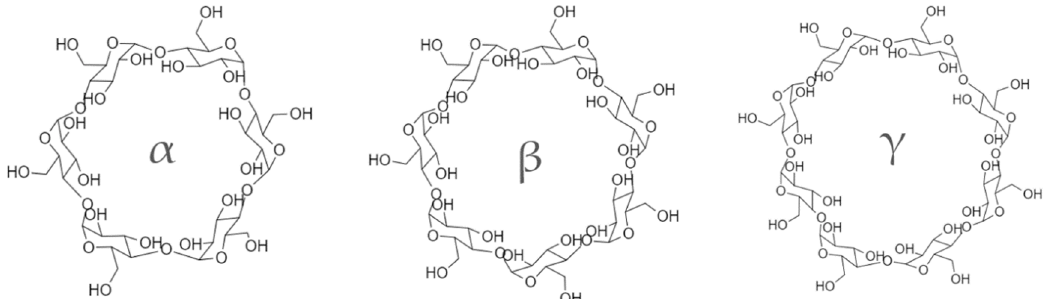
Figure 3. Chemical formulas of α -, β -, and γ -CD.